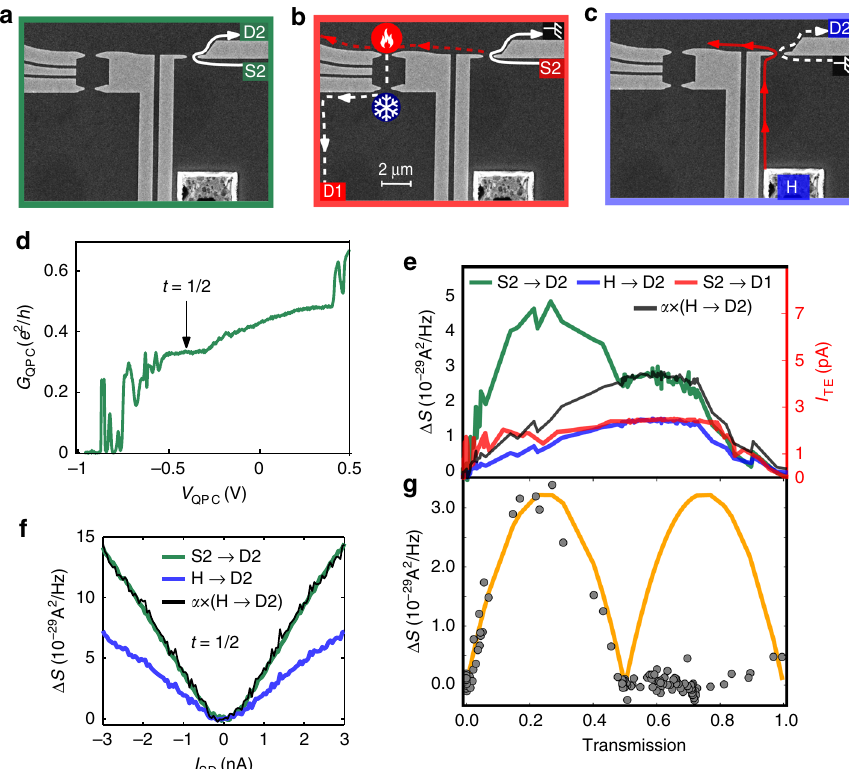
Fig. 3 Noise measurements. a Sketch of noise measurement at D2 when sourcing charge current from S2 b Sketch of thermoelectric measurement at D1 when sourcing from S2, the impinging current generates heat carried upstream by the neutral modes and converted to thermoelectric current at the QD. c Sketch of noise measurement at D2 when sourcing from H, the upstream neutral modes excited at the hot spot increase the Johnson – Nyquist noise measured at D2 d Conductance of the QPC as function of the split gate voltage. e Green: Current fl uctuations measured at D2 when sourcing from S2 as function of the transmission of the QPC. Blue: Current fl uctuations measured at D2 when sourcing from H. Black: Same as blue multiplied by a scaling factor α = 2. Red: Thermoelectric current measured at D1 when sourcing from S2. f Excess noise measured at D2 as function of the current at transmission half when sourcing from S2 (green) or H (blue). The black curve represents the noise from H to D2 (blue curve) multiplied by the scaling factor α = 2. g Gray dots: Shot noise contribution N SN = N tot − α N th = N S2 → D2 − α N H → D2 . Orange curve: expected shot noise from two